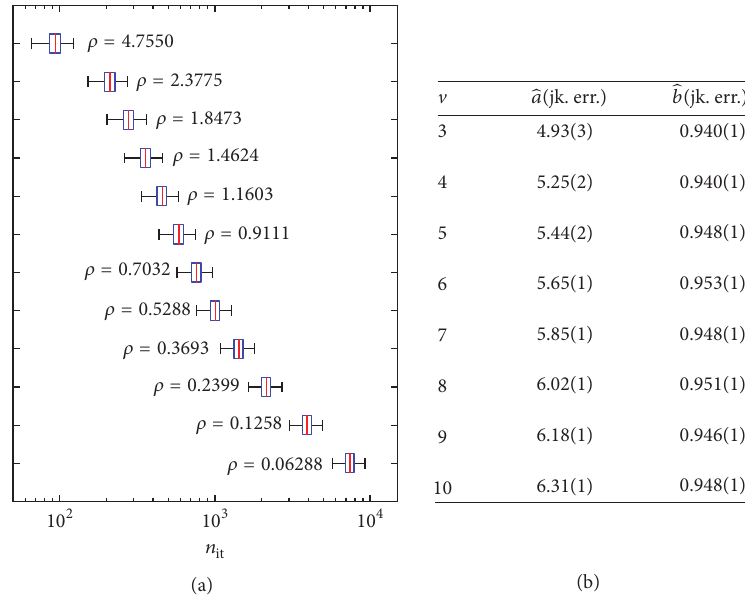
= 1.0 × 10 −7 and 𝜌 chosen as in Table 1. The distributions have been Figure 5: (a) Box-plot of 𝑛 in the GJOR scheme at V = 10 , with 𝜖 it T reconstructed from a sample of 𝑁 ≃ 10 3 eigenvalue spectra extracted from W 10 (20, 20 −1 ⋅ I 10 ) . The whiskers extend to the most extreme data point within (3/2) (75% − 25%) data range. (b) Numerical estimates of the scaling parameters 𝑎 and 𝑏 of the GJOR scheme, as obtained from = 1.0 × 10 −7 . We quote in parentheses the jackknife jackknife fits to (76) of data points with 𝜌 ≲ 1 and 𝜖 T